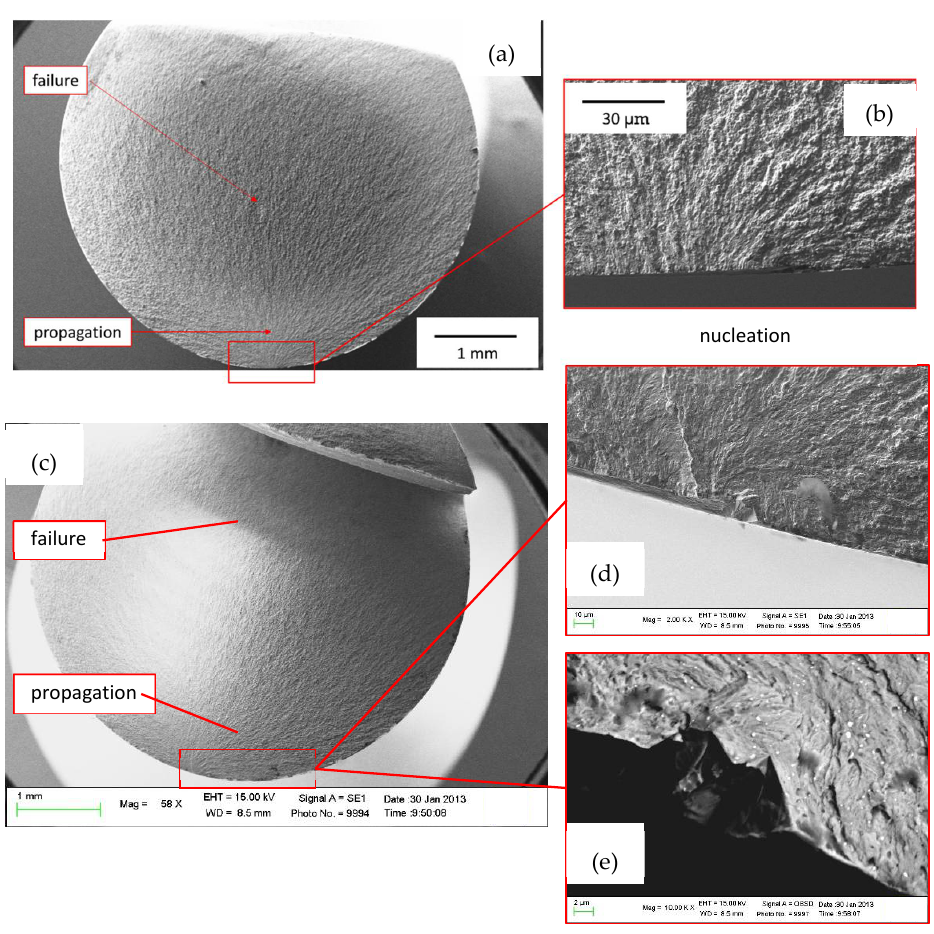
Figure 12. Fatigue fracture surface of unnotched samples. ( a , b ) crack initiation sites in the surface zone due to the accumulation of dislocation in slip bands (MPa 1150, cycles 7.5·10 6 ) and ( c – e ) presence of a flaw (MPa 1100, cycles 6.9·10 6 ).